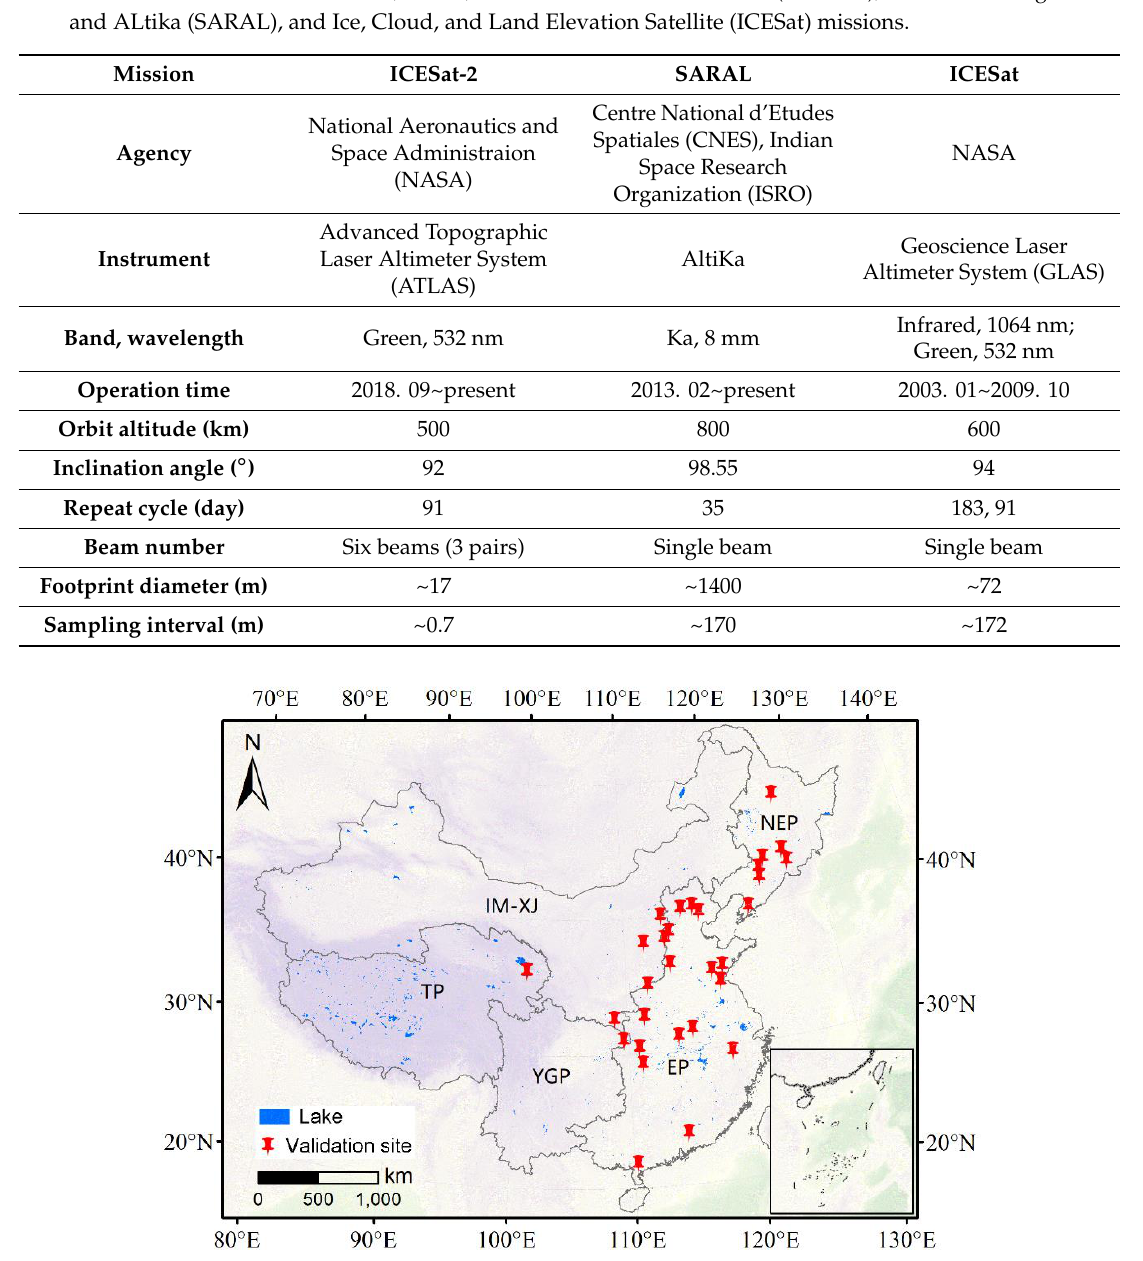
Table 1. Characteristics of the Ice, Cloud, and Land Elevation Satellite-2 (ICESat-2), Satellite for ARgos